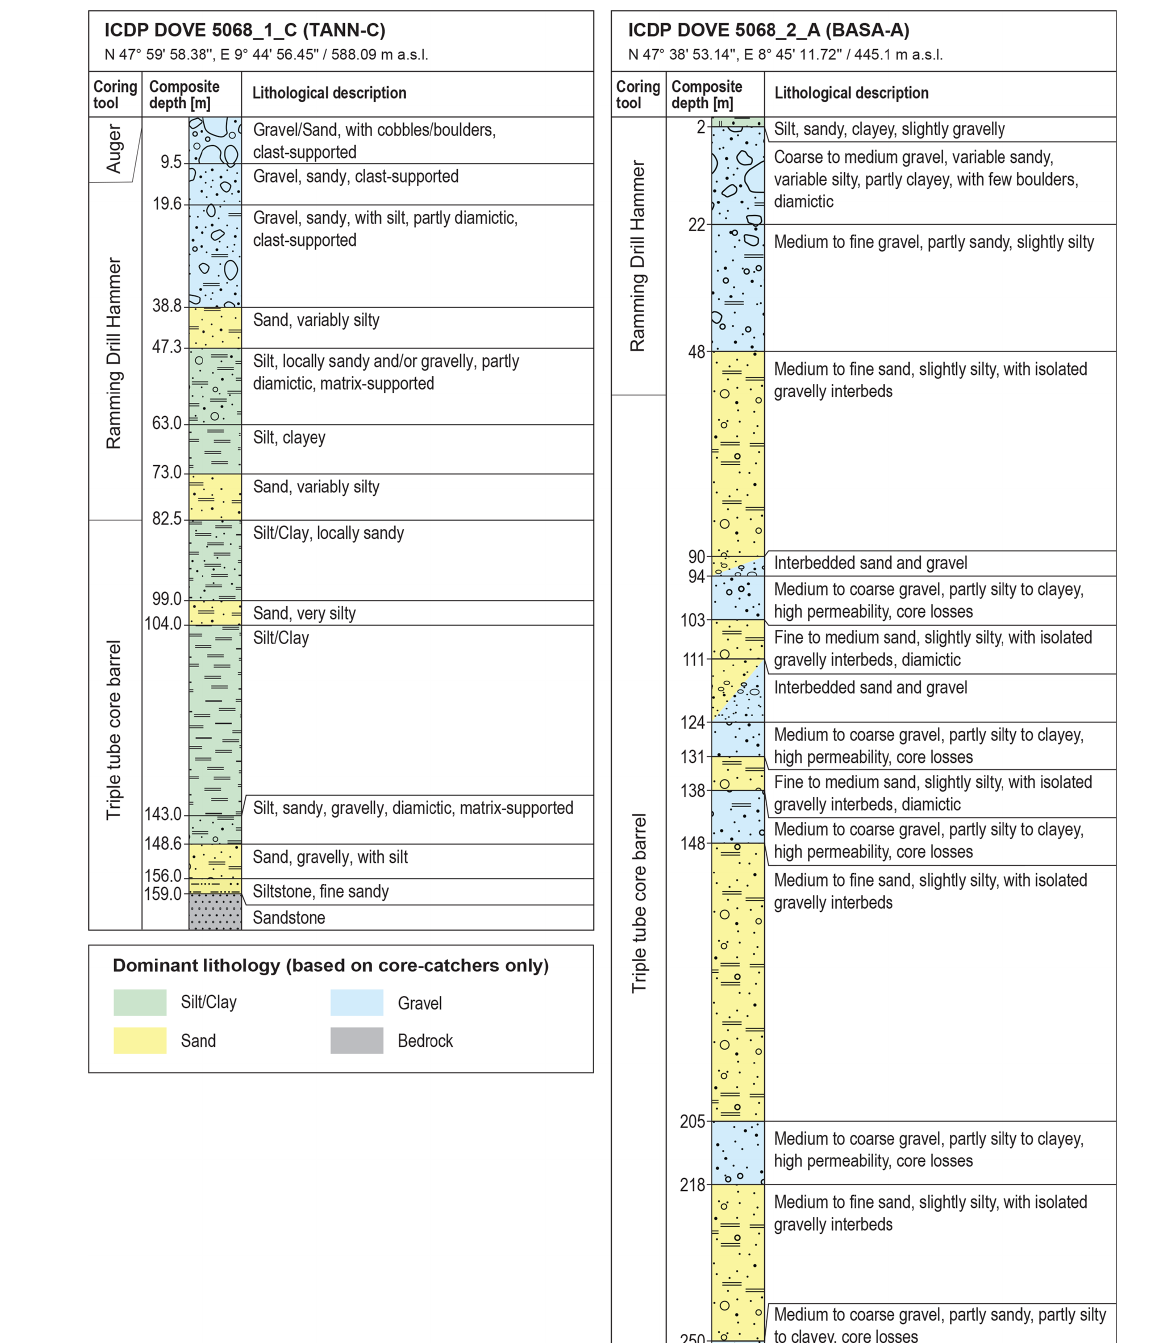
Figure 8. Core-catcher-based lithologic logs of ICDP Site 5068_1_C (Tann-C) and 5068_2_A (Basa-A) with indications of drilling tech-